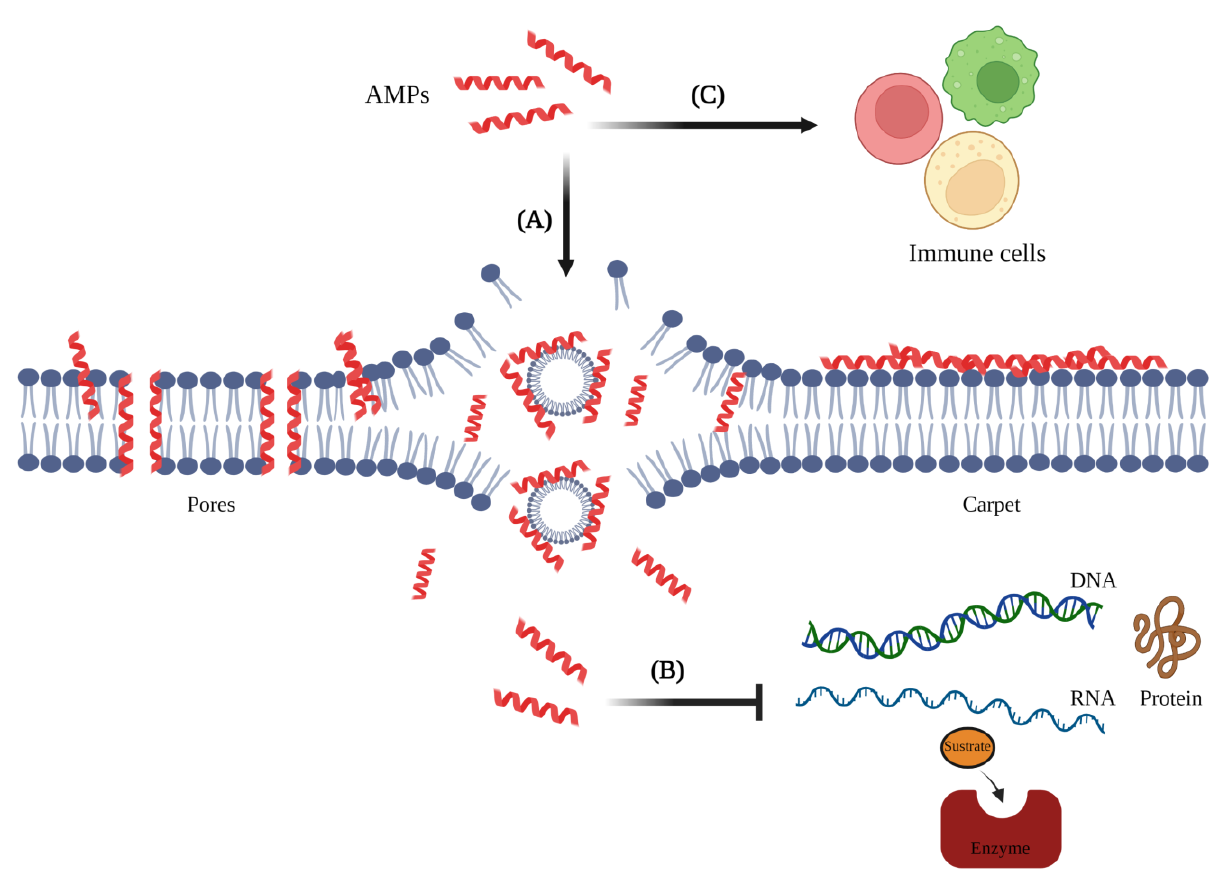
Figure 2. Mechanisms of action of antimicrobial peptides (AMPs). ( A ). Cell membrane damage. ( B ). Interaction with internal targets. ( C ). Modulation of the host innate immune response. Created with BioRender.com. (accessed on 20 February 2023)